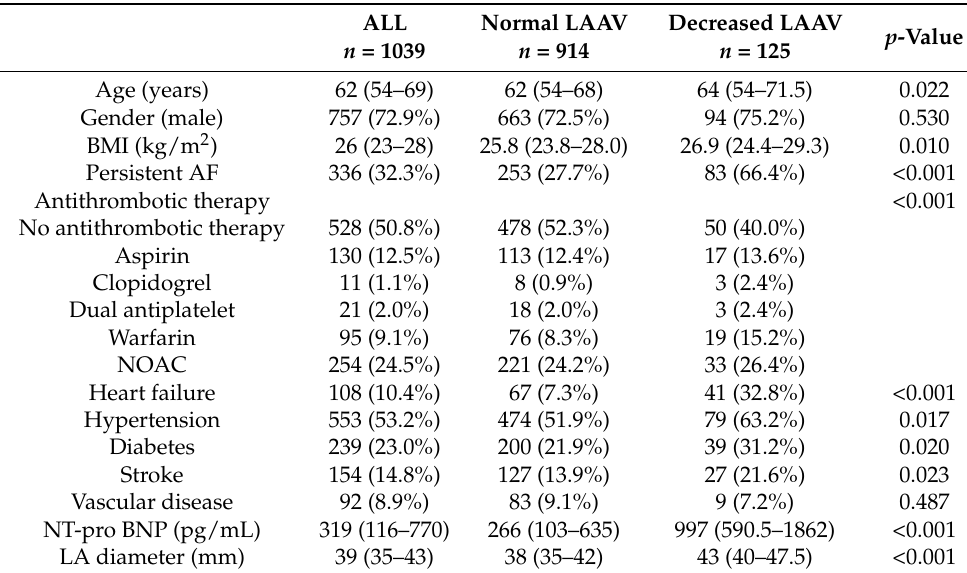
Table 1. Baseline characteristics of the records of the enrolled patients with decreased LAAV and normal